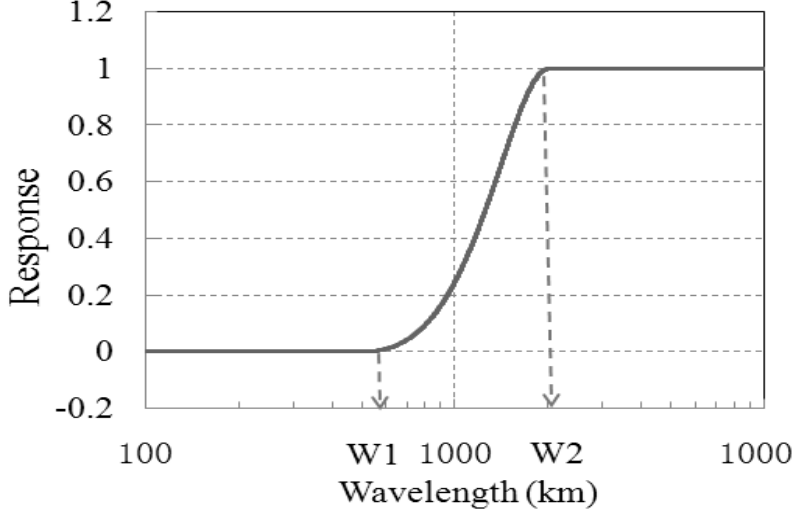
Figure 2. An example function of the 2D-DCT filter method.